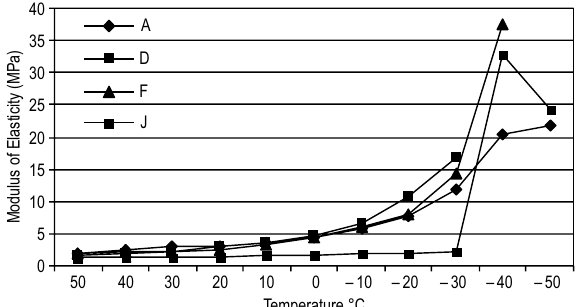
Fig. 3. Modulus of elasticity of FMS (A, D, F and J) from –50 °C to +50